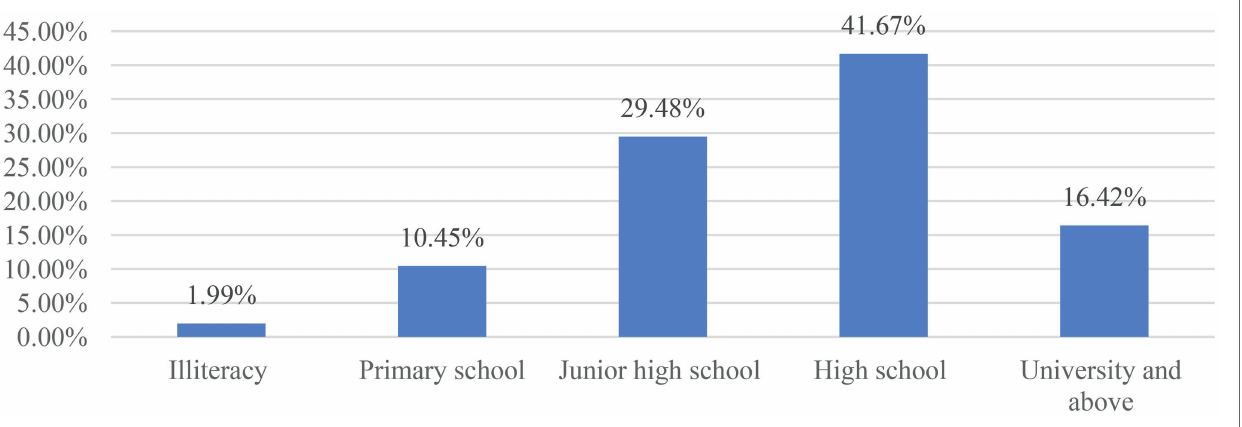
FIGURE 1 | Educational level of community